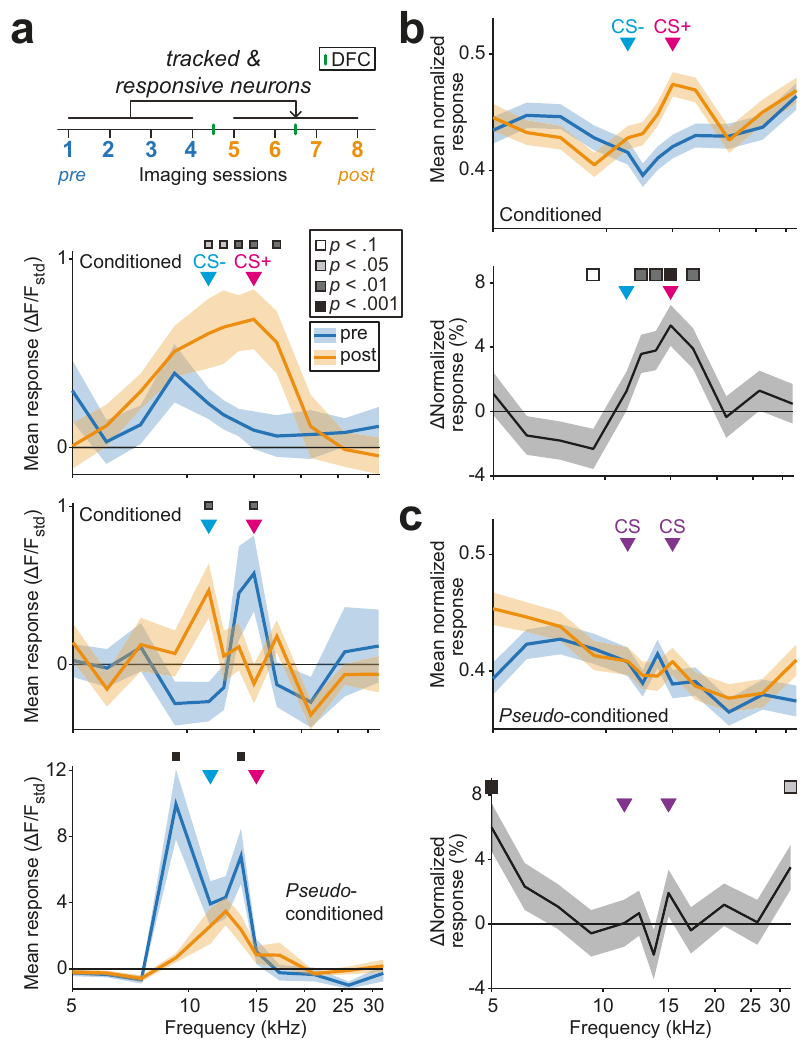
Fig. 5 Changes in frequency representation post-DFC. a Mean (±sem) response across repeated presentations ( N = 25 repetitions). We tracked the responses of neurons responsive at least once pre- and post-DFC. The panels show three example frequency response functions from tracked neurons from conditioned and pseudo -conditioned mice pre-DFC (blue) and post-DFC (orange). Signi fi cant differences in the response functions are indicated by the squares above (two-way rm-ANOVA, Tukey – Kramer post hoc analysis, Supplementary Table 1). Arrows show the frequencies of the CS − (11.4 kHz) and CS + (15 kHz) and CSc. Squares indicate signi fi cant changes (two-way rm-ANOVA, Tukey – Kramer post hoc analysis, Supplementary Table 1). b (top) Mean (±sem) normalized frequency response functions of tracked responsive neurons across all conditioned mice ( N = 14 mice, n = 879 neurons). (bottom) Mean (±sem) percent change in normalized frequency response functions of the same neurons, squares indicate signi fi cant changes (two-way rm-ANOVA, Tukey – Kramer post hoc analysis, Supplementary Table 1). c (top) Same ( b ) for pseudo-conditioned mice ( N = 9 mice, n = 626 neurons). (bottom) Percent change in normalized frequency response functions for the same cells as above, squares indicate signi fi cant changes (two-way rm- ANOVA, Tukey – Kramer post hoc analysis, Supplementary Table 1). Source data are provided as a Source data fi